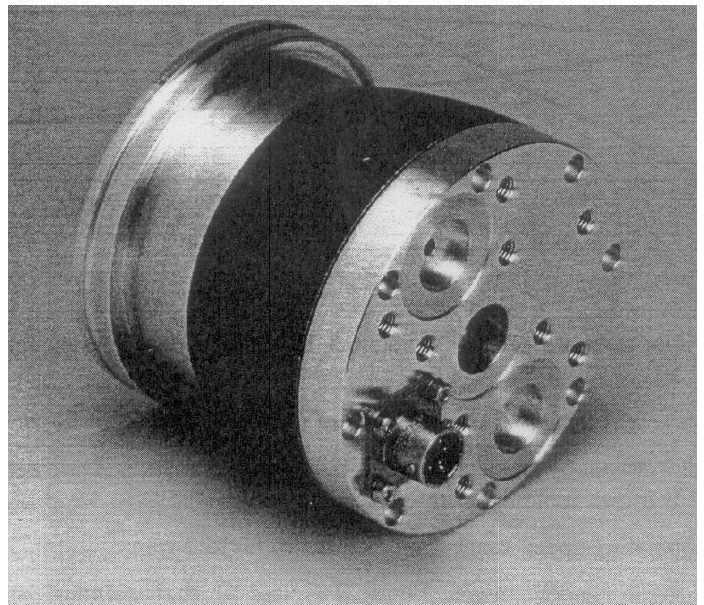
Fig. 1. Turbomolecular pump – Courtesy ALCATEL-CIT.